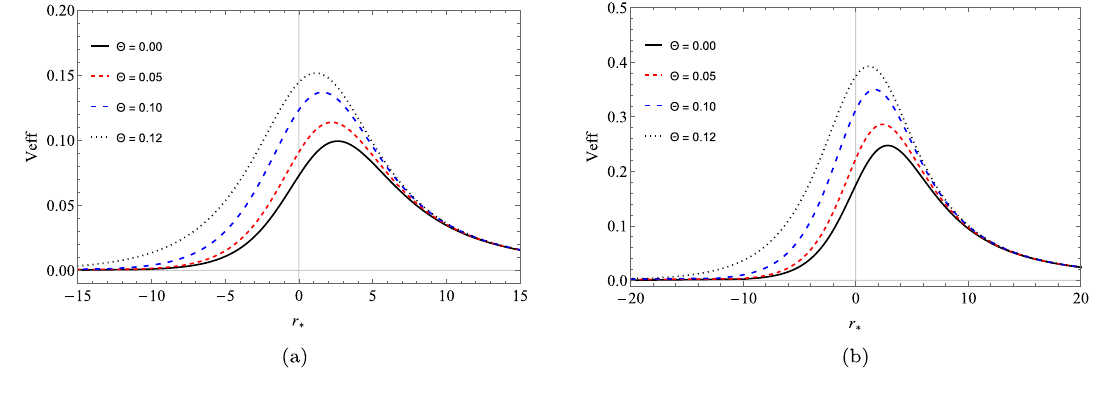
1 and ( b ) l 2 ( a ) l = = ∗